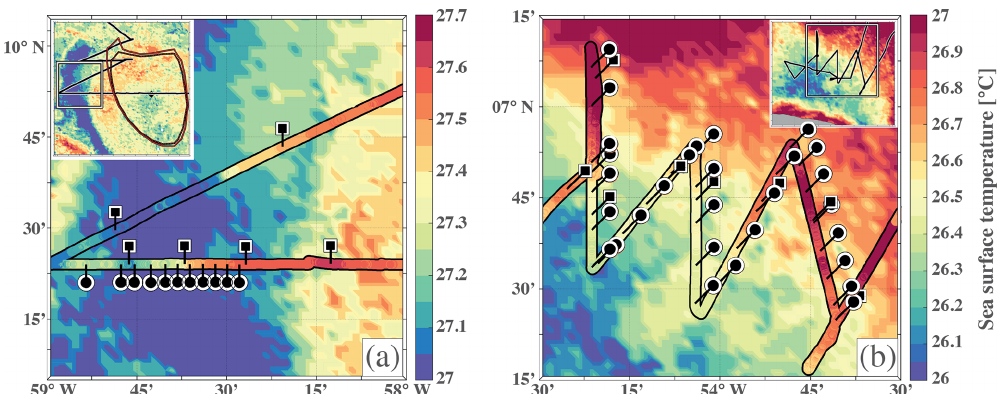
Figure A1. Maps of CLS SST ( ◦ C) for (a) 25 January 2020 and (b) 2 February 2020, with the Atalante track during the first (26 January) and second (2–3 February) intensive leg. The color shows the SST measured by the ship’s thermosalinograph (TSG) at 5m depth, and the ticks show the location of Vaisala (squares) and Meteomodem (circles) radiosonde launches. Inserts in the upper corners, where the black lines indicate the ship’s course, show the larger-scale view of the corresponding scenes with the geographical imprint indicated by white squares. In the panel insert (a) , the closed contours and the black diamond indicate, respectively, the edges of an anticyclonic eddy and the position of its center.